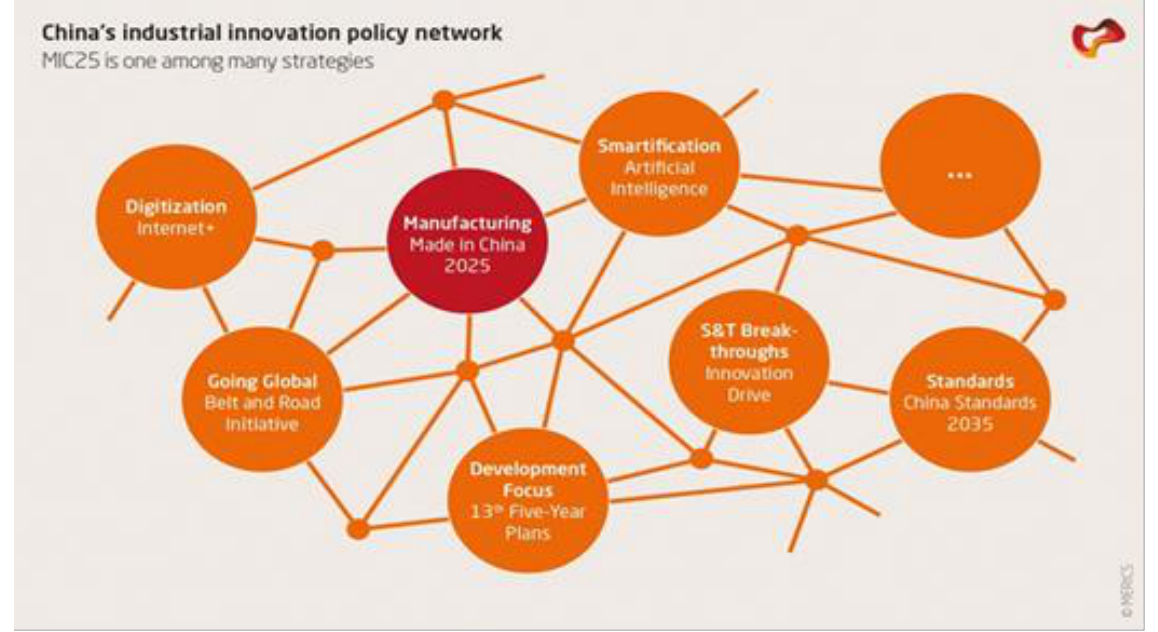
Figure 4. China Standards 2035. Source: Merics Twitter.